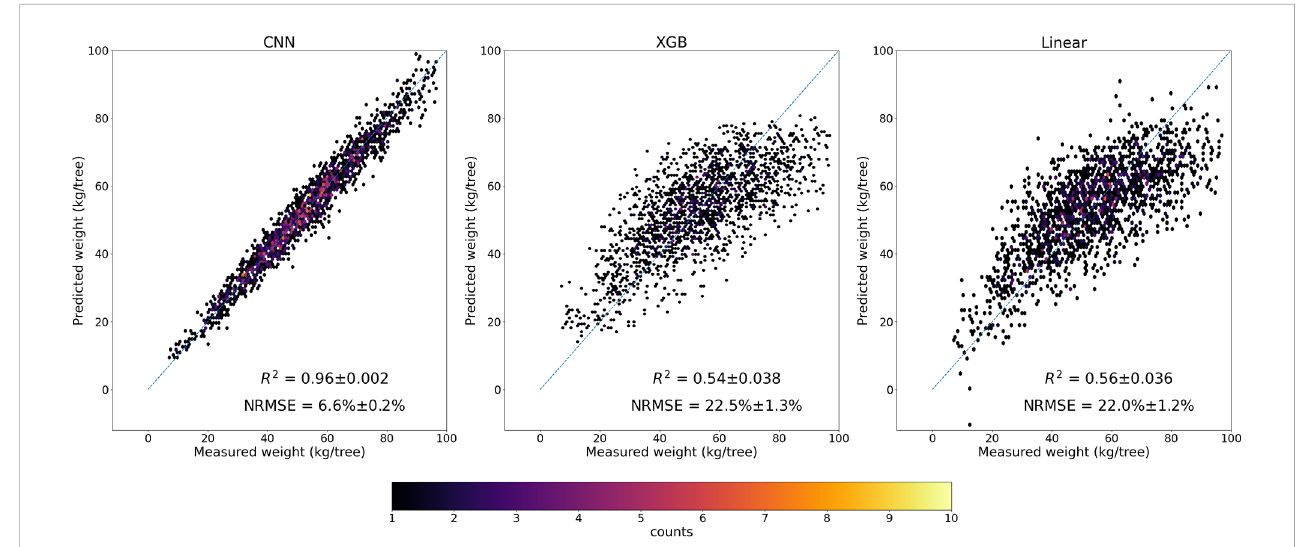
FIGURE 6 Scatter plots of predicted yield by the full CNN model, XGB, and Linear models vs. measured